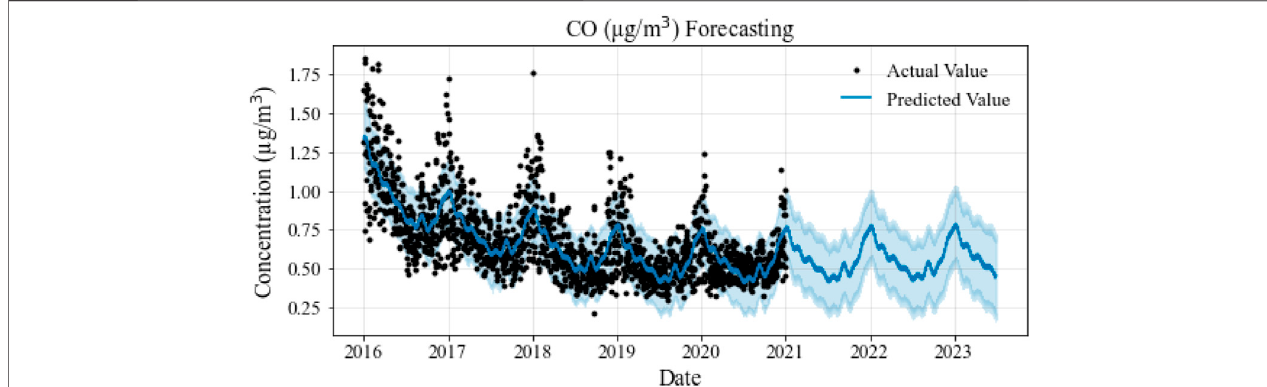
FIGURE 7 | CO (µg/m 3 ) forecasting in jiangsu province.